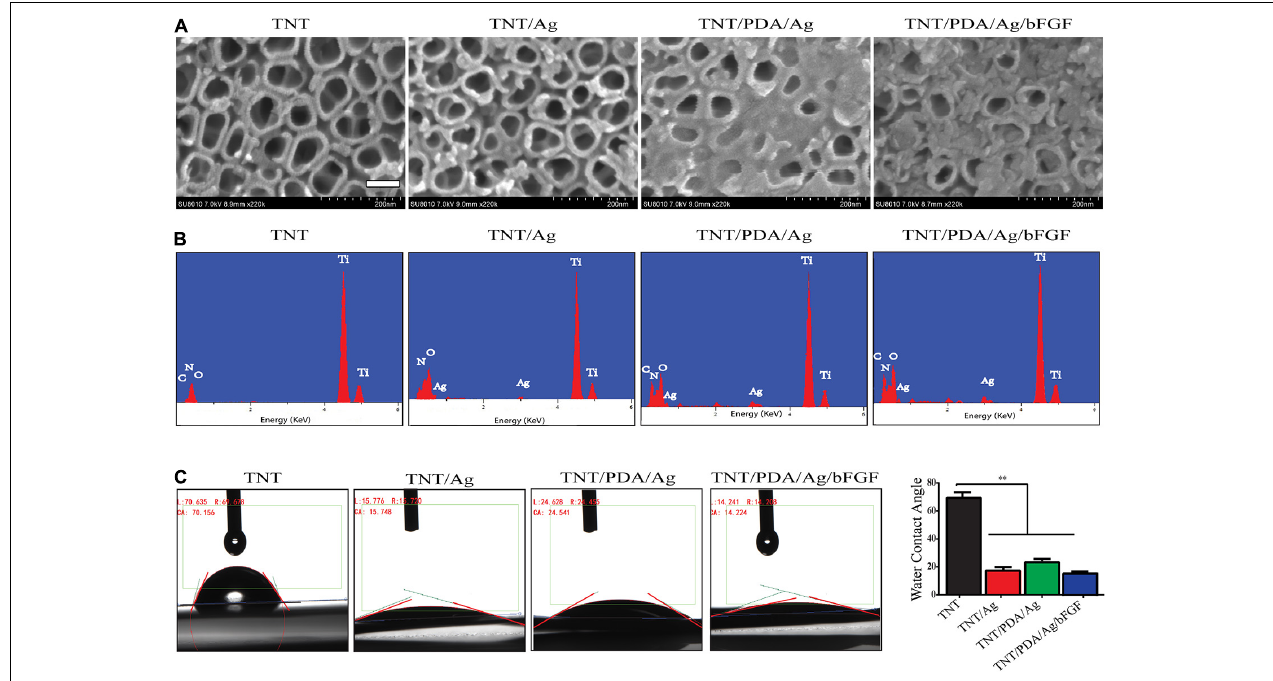
FIGURE 3 | Characterization of modified Ti samples. (A) SEM images of Ti challenged at 20 V: TNT, TNT/Ag, TNT/PDA/Ag, and TNT/PDA/Ag/bFGF. Ag nanoparticles on pores could be detected at nanotube inner surfaces in TNT/Ag. TNT/PDA/Ag and TNT/PDA/Ag/bFGF were partially covered with adherent particles, and the number of these particles increased in TNT/PDA/Ag/bFGF. Scale bar represents 500 nm. (B) Energy-dispersive X-ray spectroscopy (EDS) of modified Ti samples. TNT was mainly composed of titanium (Ti) with traces of nitrogen (N), oxygen (O), and carbon (C). Ag could be detected in TNT/Ag, TNT/PDA/Ag, and TNT/PDA/Ag/bFGF. (C) Water contact angle study indicated a hydrophilic surface feature in TNT/Ag, TNT/PDA/Ag, and TNT/PDA/Ag/bFGF. Data are presented as mean ± standard deviation; ∗∗ p <